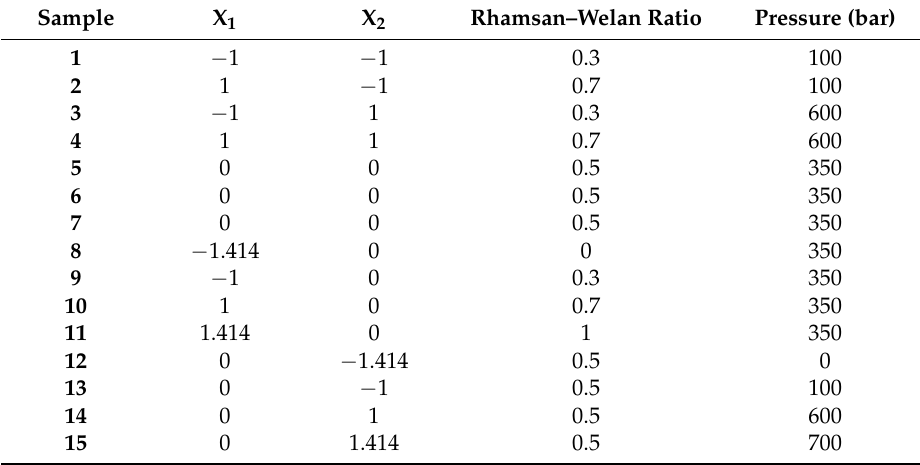
Table 1. Experimental design carried out for the continuous phases studied. X 1 = rhamsan–welan ratio. X 2 = homogenization pressure. (Rhamsan–welan ratio = 0 means 100 wt % of welan gum and 1 means 100 wt % of rhamsan